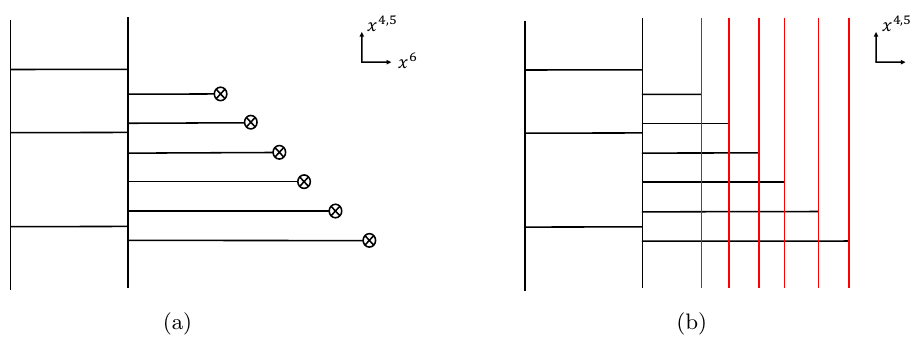
Figure 1 . (a): brane con(cid:12)guration for 4d N = 2 SQCD. The (cid:12)gure shows the case with N = 3. (cid:10) represents an N = 2 D6-brane. (b). Brane con(cid:12)guration obtained after rotating the N = 2 D6-brane in (cid:12)gure 1(a). The N = 1 D6-branes are depicted as red vertical lines. NS5-branes [43] (see (cid:12)gure 1(a)). The various branes extend in ten-dimensional (cid:13)at